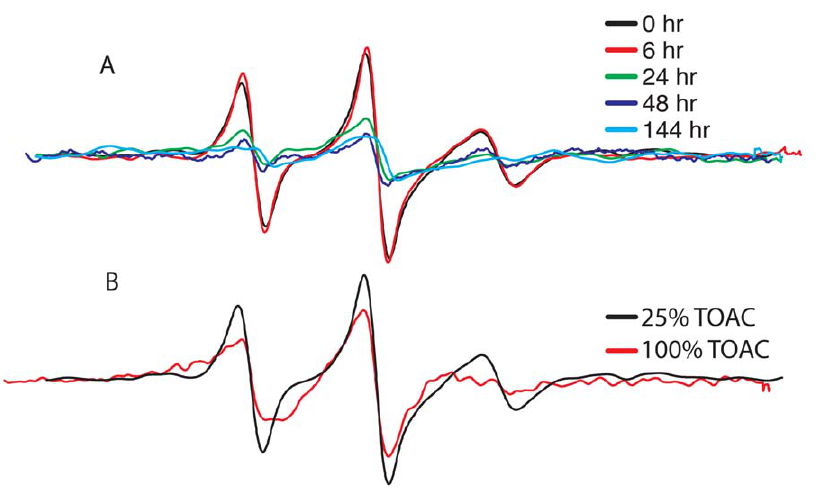
Figure 7. Spectral broadening due to immobilization and dipolar interaction in assemblies of A b . (A) Changes in the correlation time of A b (26TOAC) with increased incubation time. To mainly observe the effects on dynamics, the spins in the A b preparation were diluted with wild-type peptide (A b (1–40) ), so that the sample contained only 25% A b (26TOAC) . (B) Comparisons of EPR spectra of 80 m M A b O preparations containing either 25% (black line) or 100% (red line) A b (26TOAC) . Both spectra were acquired after 1 hour at room temperature.